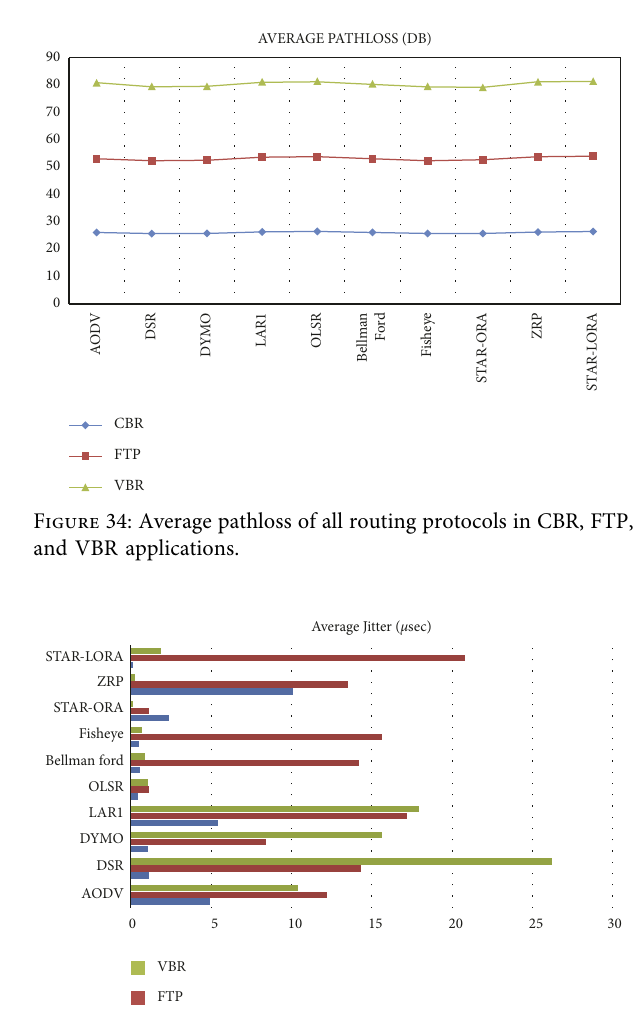
Figure 33: Percentage of utilization of all routing protocols in CBR, FTP, and VBR applications.